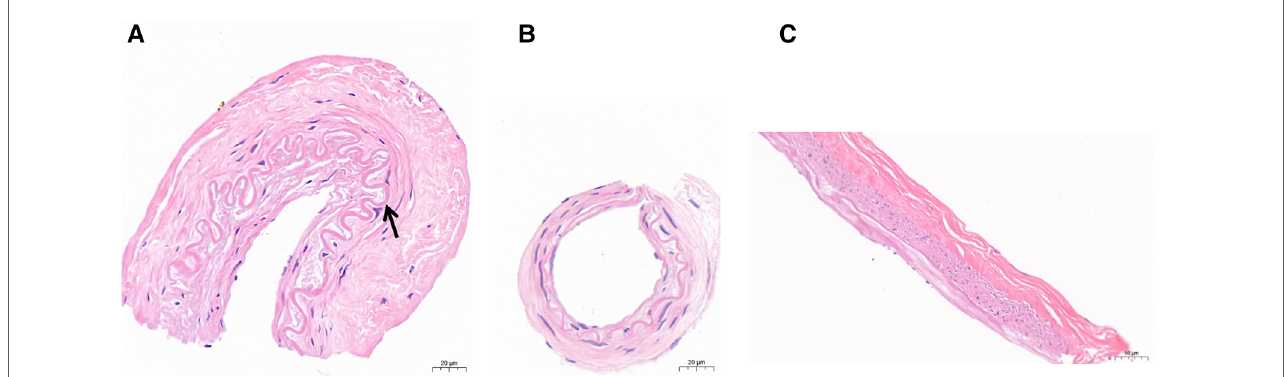
FIGURE 3 ( A,B ): Photomicrographs of specimens of the PSCAs (MCA) taken from patients with moyamoya disease between non-M-PSCAs ( A ) and M-PSCAs ( B ) disease showing intimal hyperplasia and curved internal elastic lamina ( A , arrow), and specimens of the PSCA ( C ) taken from control subjects. Scale bar, 20 µ m ( A,B ) and 50 µ m ( C ); Hematoxylin and eosin stain, original magni fi cation, ×40 ( A,B ) and ×20 ( C ).